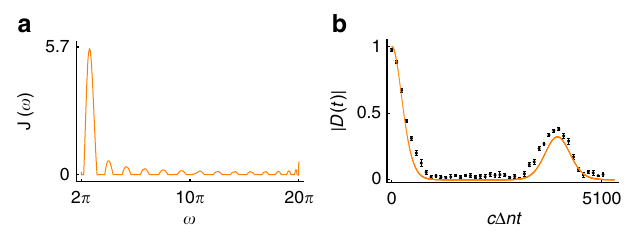
Fig. 4 Synthetic spectral density and corresponding decoherence dynamics of a qubit. a A chosen spectral density J ( ω ) used in Eq. (6). The unit of frequency is λ 0 / c with λ 0 = 800 nm. b Corresponding theoretical and experimental dynamics of the decoherence function (for more details, see the main text). The black dots correspond to measurement data and the error bars are mainly due to the counting statistics, which are standard deviations calculated by the Monte-Carlo method. The evolution time is given by effective path difference in units of λ Fig. 3e, h for the two cases. This again re fl ects the crucial role that θ ( ω ) plays in developing and implementing generic simulator for dephasing.